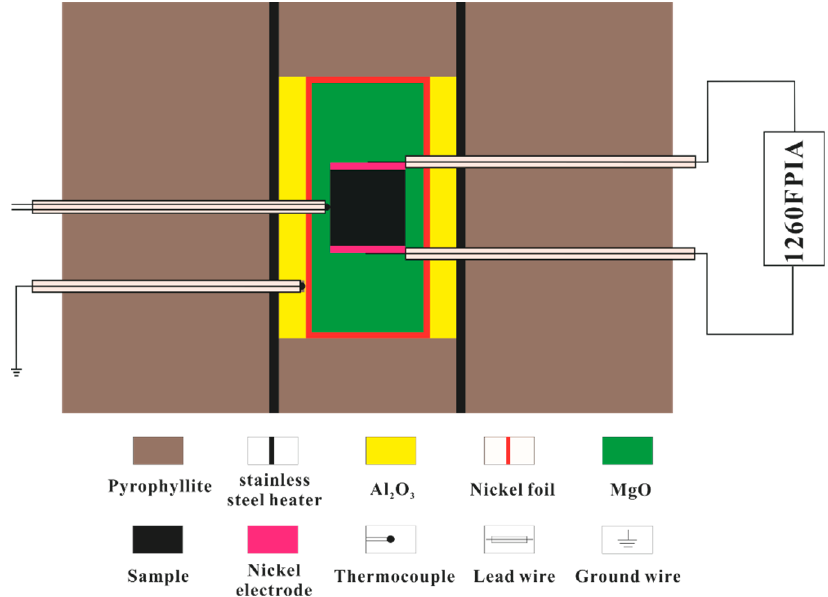
Figure 1. The cross-sectional experimental setup for electrical conductivity measurements at high temperature and high pressure.